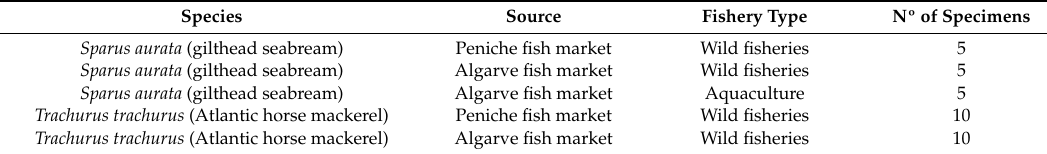
Figure 1. Localization of the fish sampling regions studied. ( a ) Population density on Portuguese coast (adapted) [16]; * indicates aquaculture sampling site. ( b ) Sea surface temperature during the summer of 2017 in Europe. Black arrows indicate the sampling sites on the Portuguese coast (adapted) [17]. Table 1. Fish samples acquired during this study, their source, and fishery